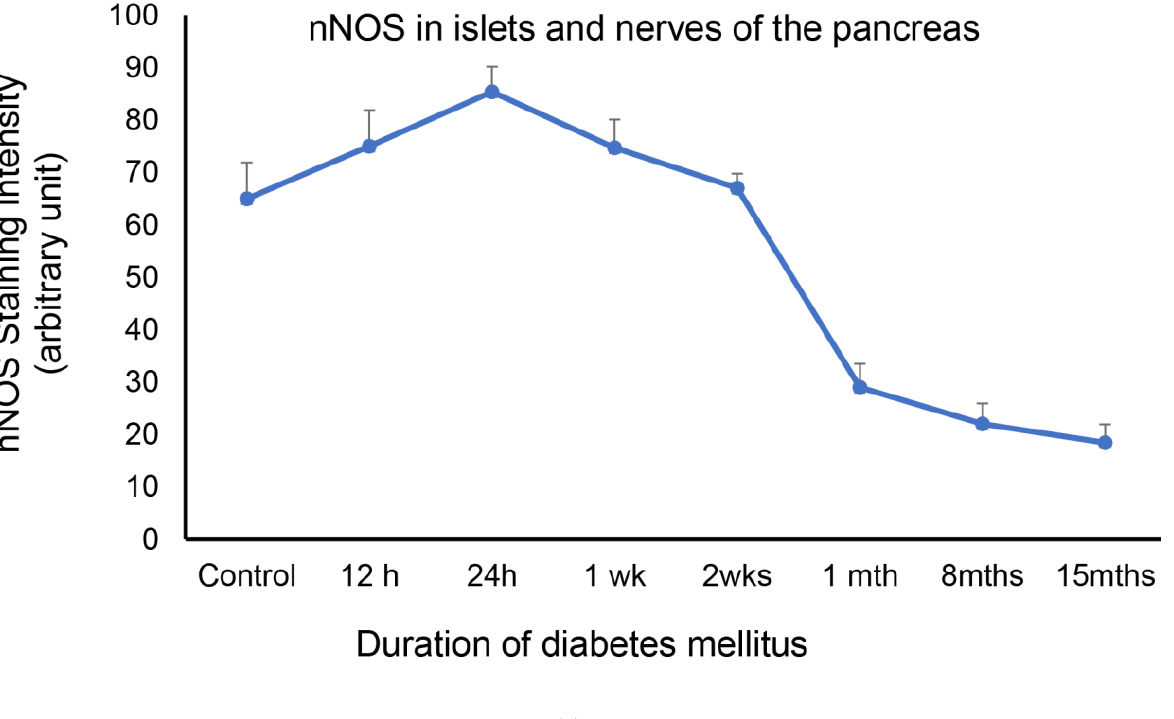
Figure 2. ( a ) Western blot image showing pancreatic (islets and pancreatic nerves) contents of nNOS at different stages of diabetes mellitus. Note the increase in nNOS content reached its peak 24 h after the induction of diabetes. The pancreatic tissue level decreased gradually after reaching its peak. ( b ) Densitometric analysis of the Western blot is shown in ( a ). ( c ) Shows the immunofluorescence staining intensity of nNOS in the pancreas (islets and pancreatic nerves) over the experimental period. Note the peak of gradual increase in nNOS, 24 h after the onset of diabetes. (n = 6).